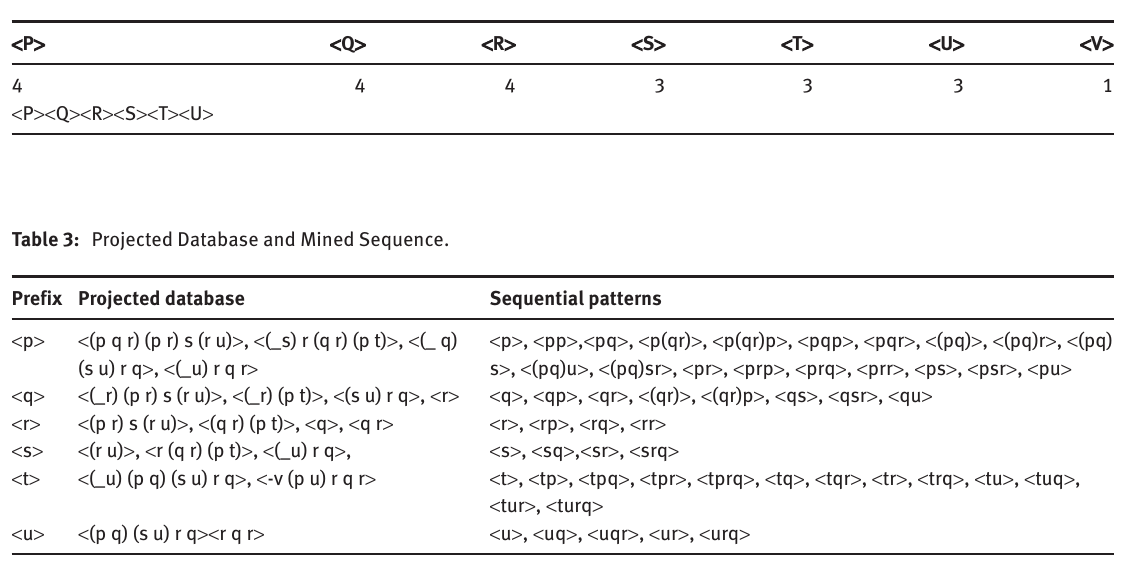
Table 2: Obtained Length-1 Frequent Item Sets.